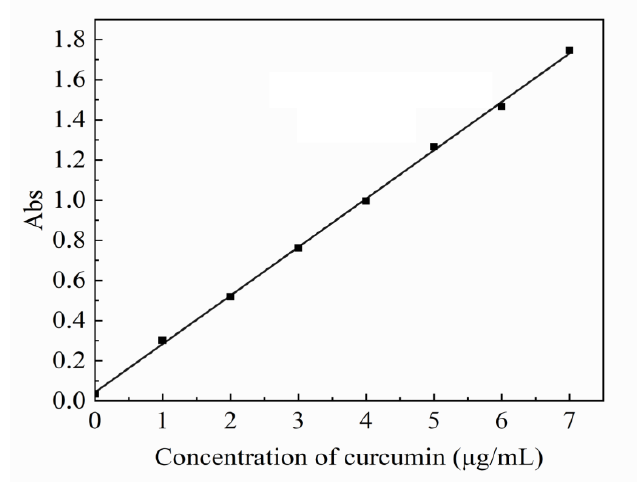
Figure 6. Standard curve of curcumin as the model drug.